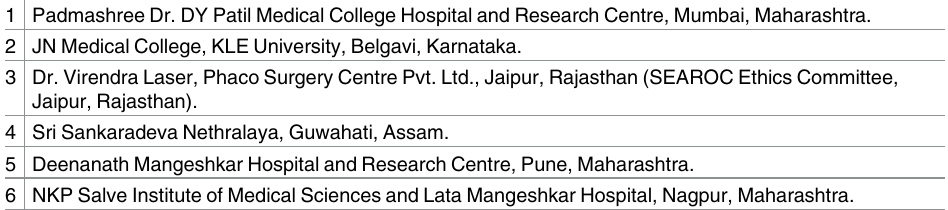
Table 1. Participating centersin India.